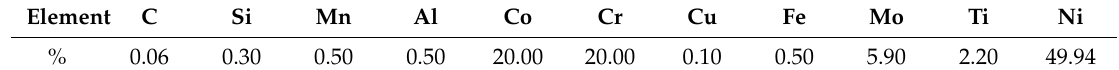
Table 1. Nimonic 263 chemical composition (%).